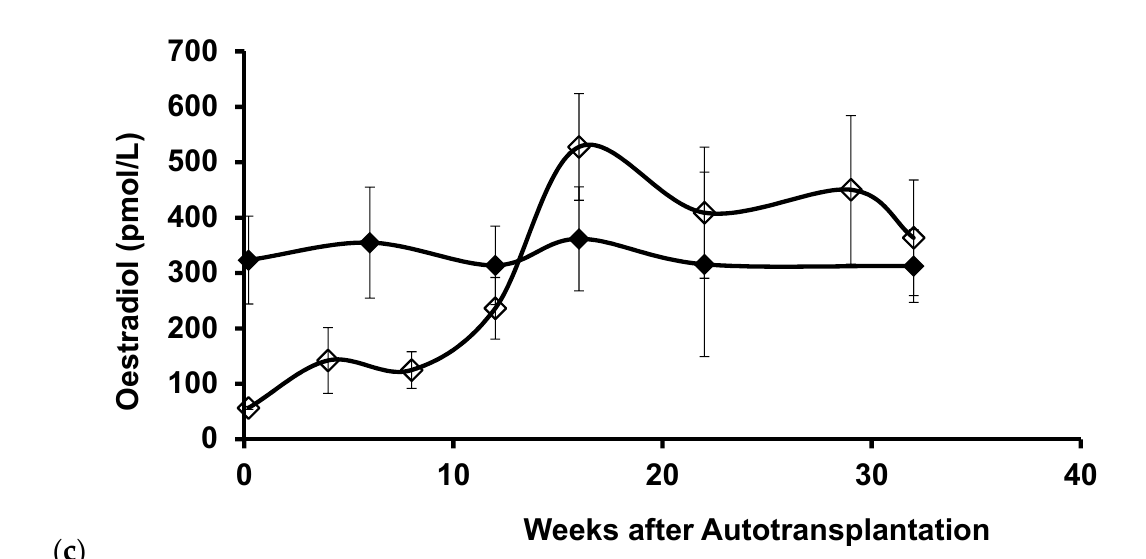
Figure 1. The average concentrations of FSH ( a ), LH ( b ) and oestradiol ( c ) (±SEM) during the first 40 weeks in women trans- planted with ovarian tissue in relation to whether they were menopausal or not menopausal at the time of transplantation. AMH was only measured in a subgroup of patients because the assay was not avail- able when the first cases received OTT. In the menopausal group, four out of five meas-